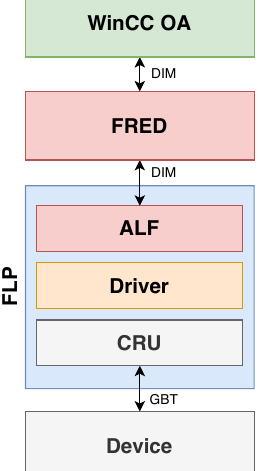
Figure 3. Connection of individual modules of the ALICE Low Level Front End Device (ALFRED)